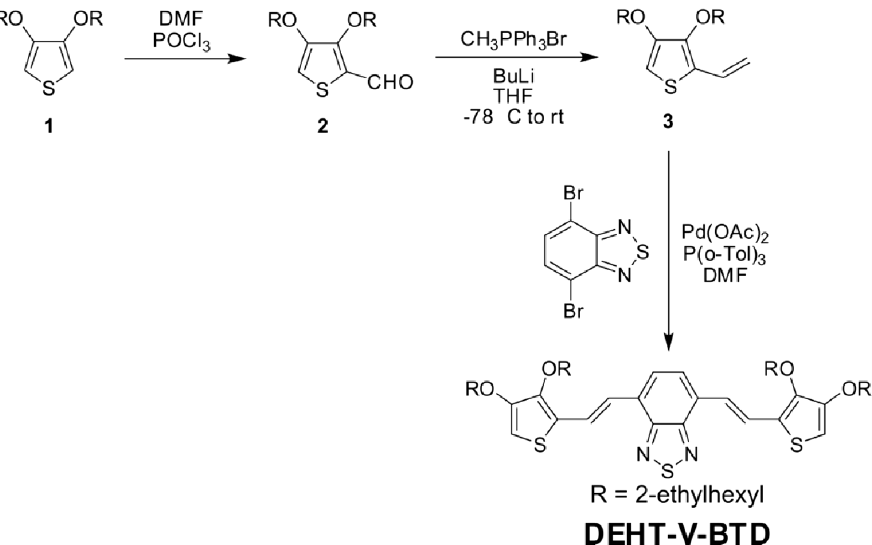
Figure 2. Synthesis of monomer